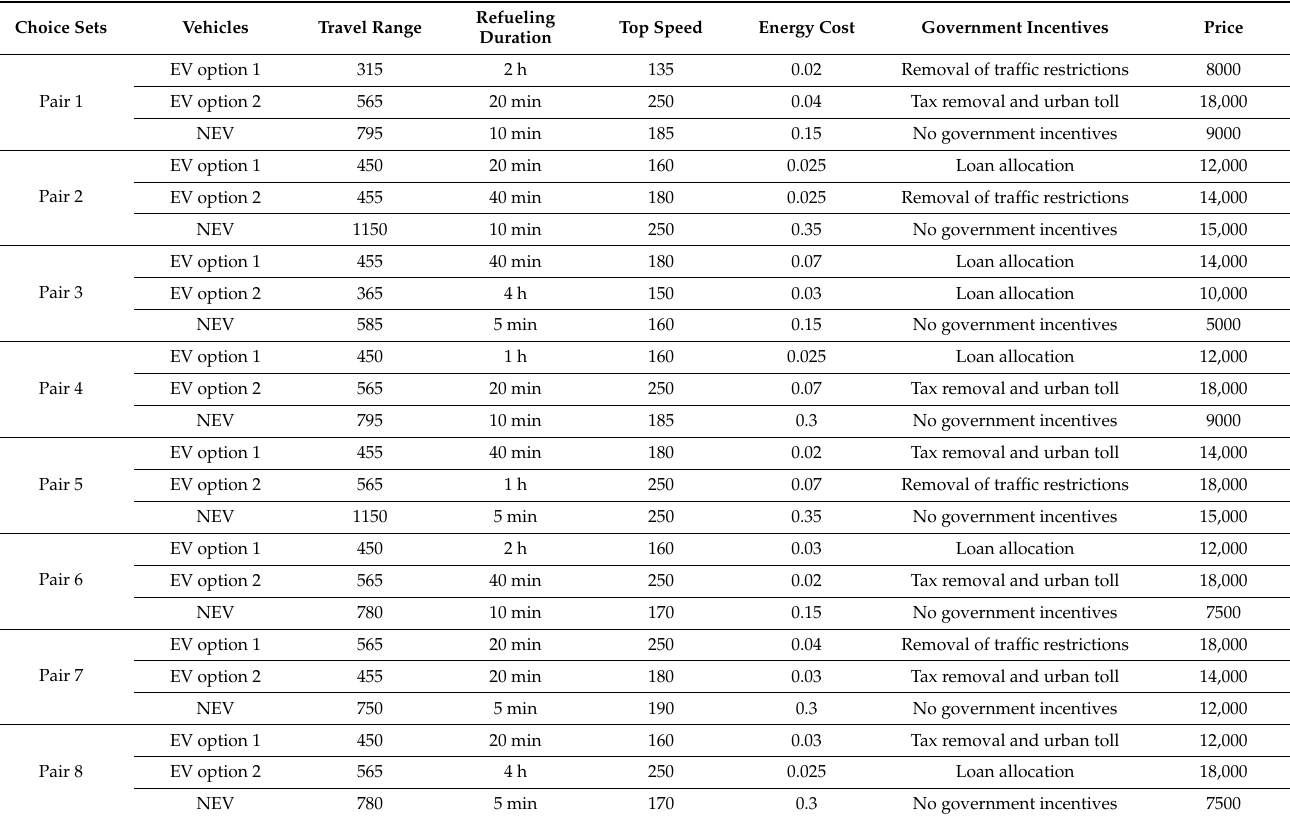
Table 4. Alternative attribute sets are offered to customers in questionnaires.